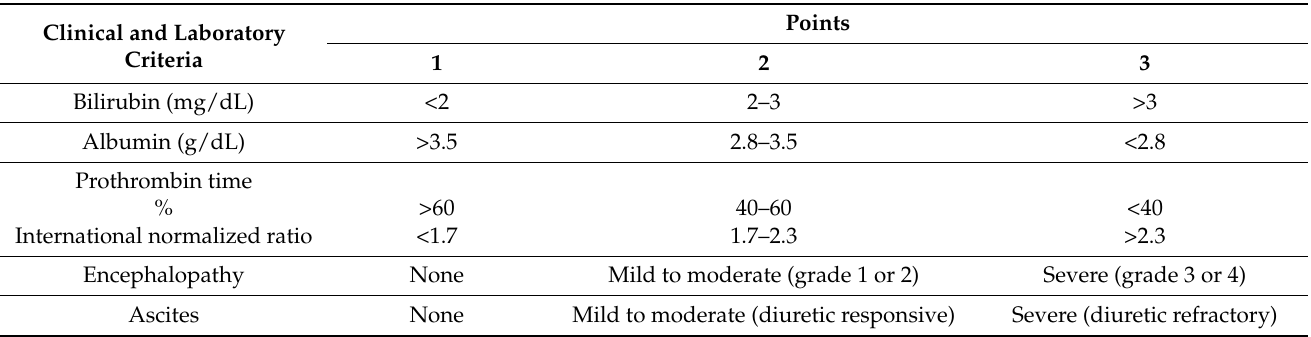
Table 5. Child–Pugh